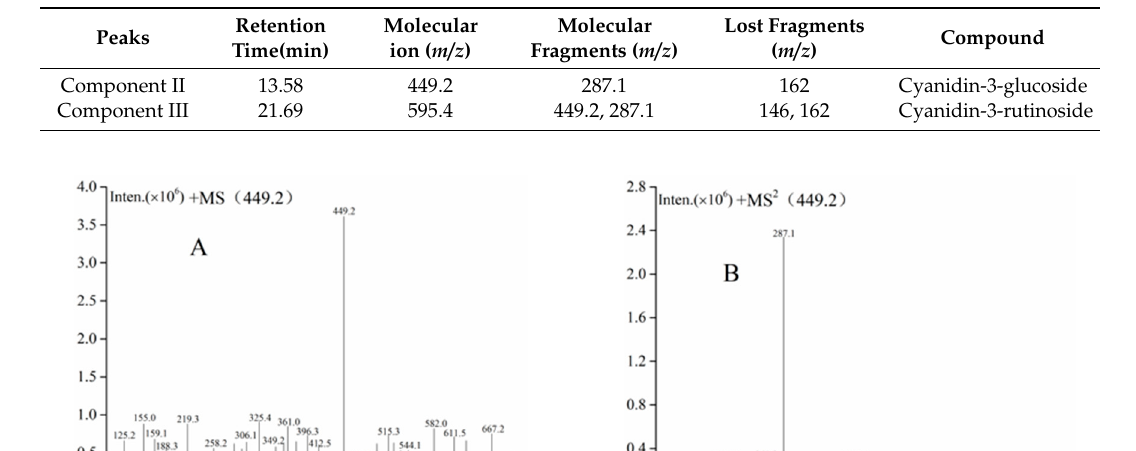
Table 5. Identification of anthocyanins in raspberries. Figure 7. High-performance liquid chromatography (HPLC) chromatogram of component II ( A ) and component III ( B ).